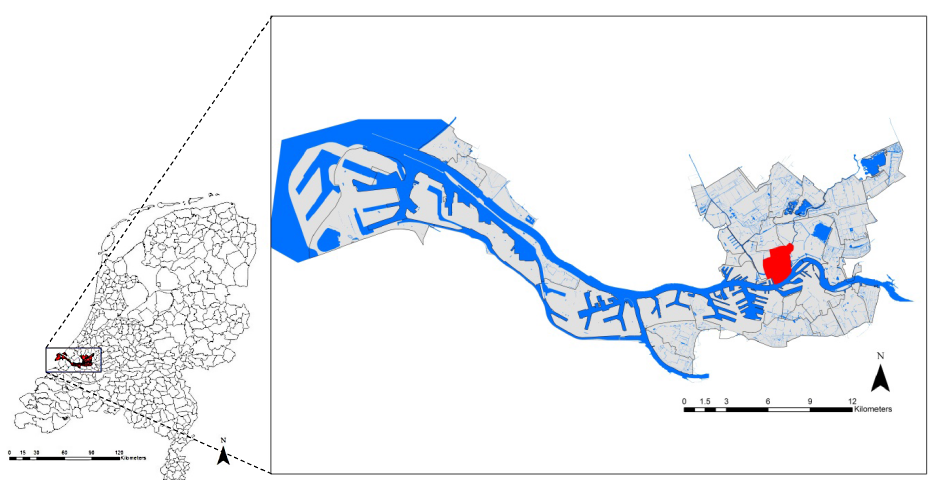
Figure 1. Localisation of Centrum district (in red in the right panel), situated in Rotterdam urban area (right panel and in red in the left panel), the Netherlands (left